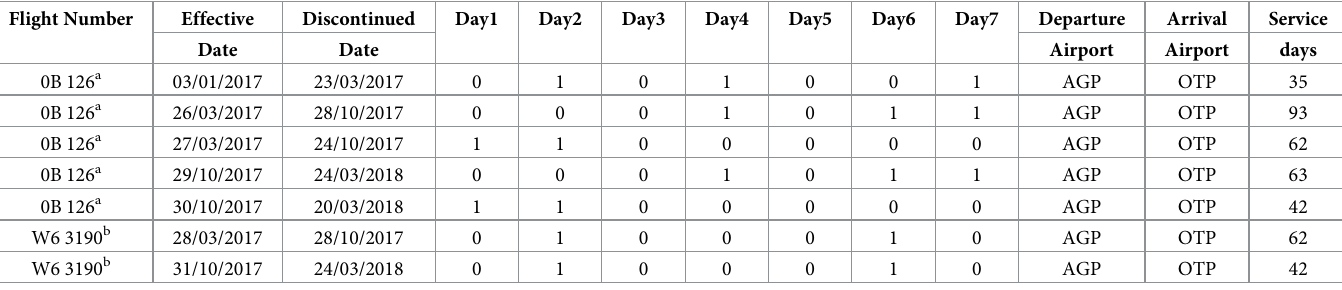
Table 1. An example of IATA flight